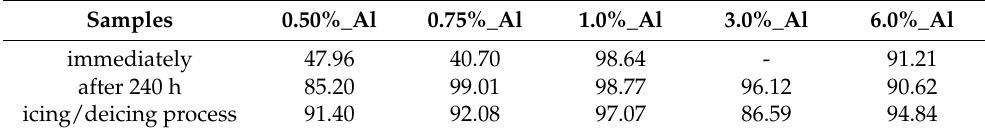
Table 6. Calculated coating protection efficiency (CPE, %) for non-modified and modified epoxy coating immersed immediately and after 240 h in 3.5% NaCl and after the icing/deicing